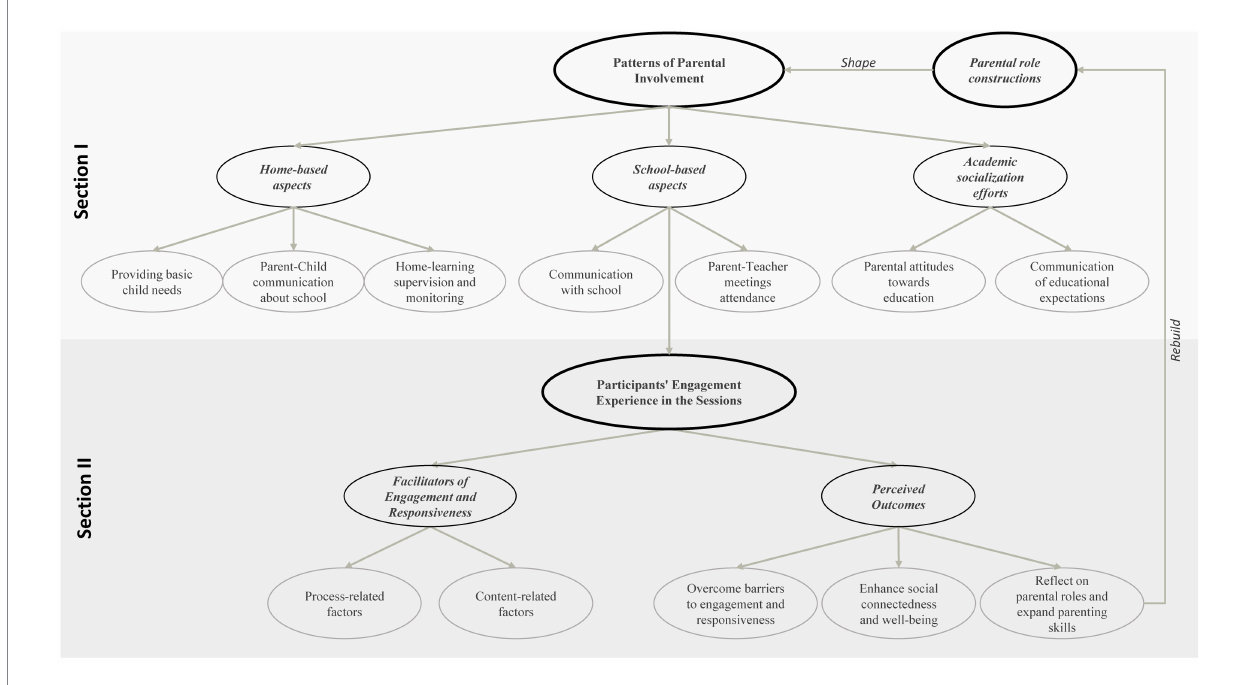
FIGURE 1 Visual map of the themes, subthemes, and emerging relationships developed through thematic